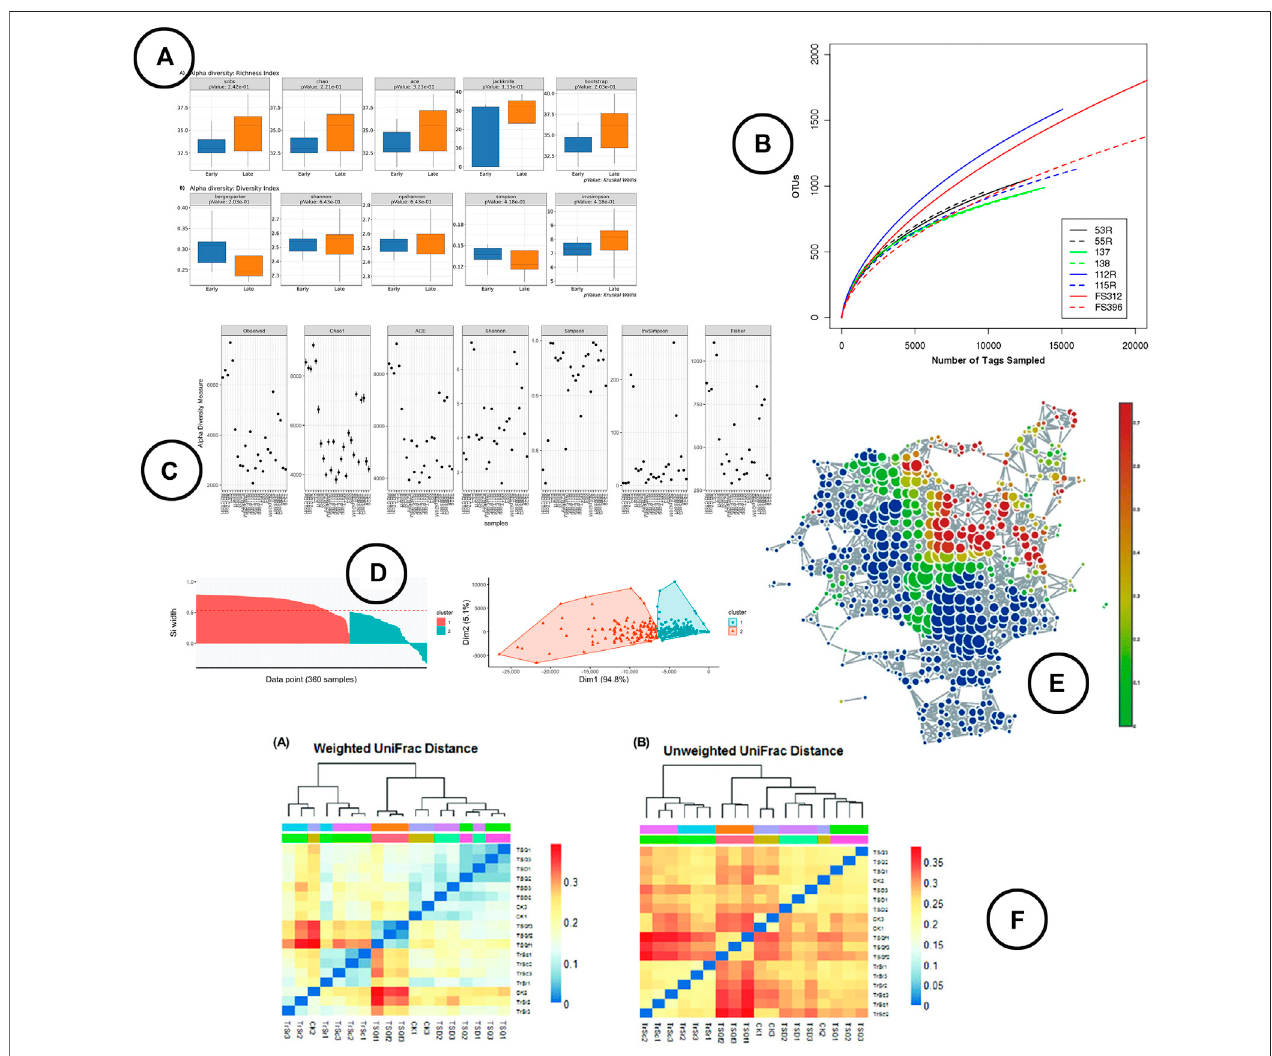
FIGURE 4 | An overview of the visual encodings used to display within (alpha) and between (beta) diversity; (A) alpha diversity metrics compared between groups bymeansofbox-plotsinBiomMiner(Shamsaddinietal.,2020), (B) rarefactioncurveshowingthenumberofOTUsbysequencesizeinMothur(Schlossetal.,2009), (C) alpha diversity metrics visualized using scatter plots in Phyloseq (McMurdie and Holmes, 2013), (D) beta diversity visualized using ordination in iMAP (Buza et al., 2019), (E) a node-link diagram produced using TDA in TMAP to display beta diversity (Liao et al., 2019), (F) heatmap visualizations showing beta diversity distance matrices (Lei et al.,